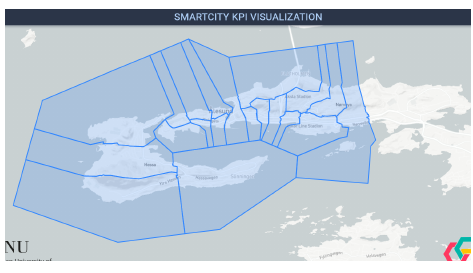
Figure 11. Districs of ˚Alesund.